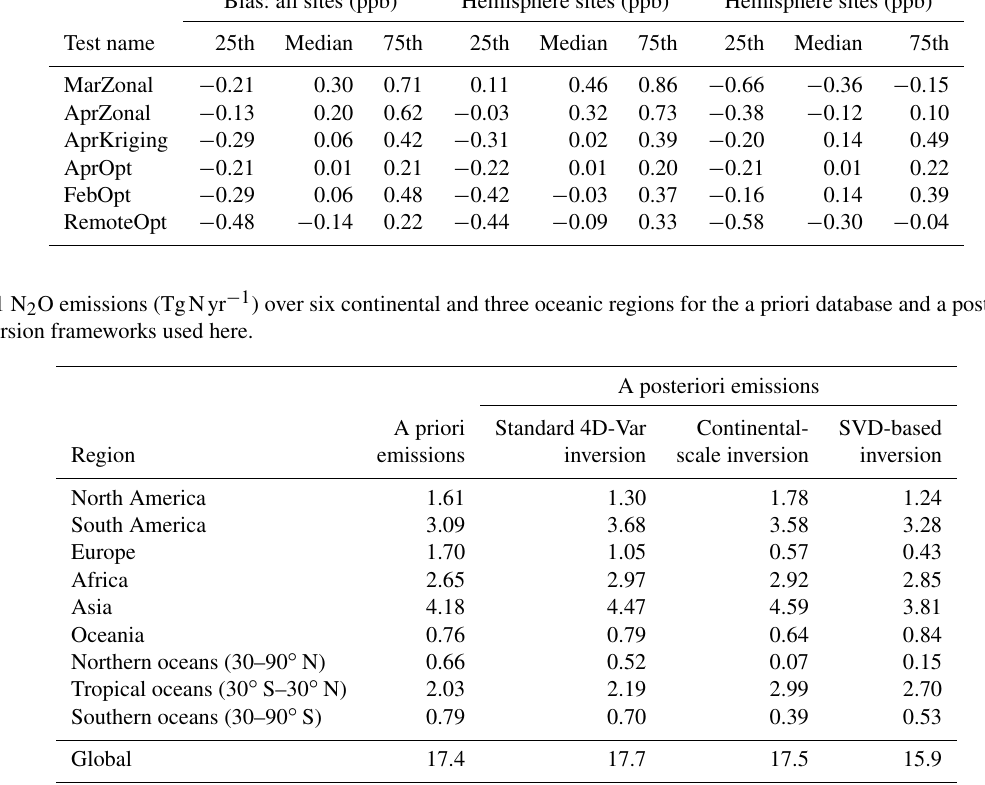
Table 2. Initial bias statistics for each of the six initial conditions with respect to observations at all sites, Northern Hemisphere sites, and Southern Hemisphere sites. Statistics are calculated for the first week of the simulation (1–7 April 2010). Bias: Northern Bias: all sites (ppb)